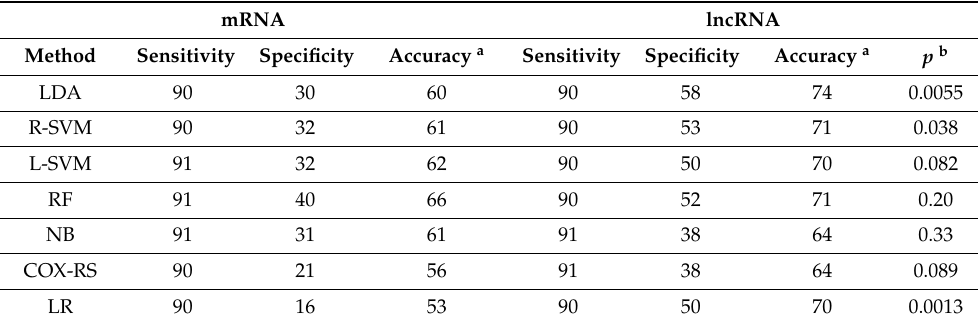
Table 2. Classification with ≥ 90% sensitivity threshold using seven individual machine learn- ing methods.